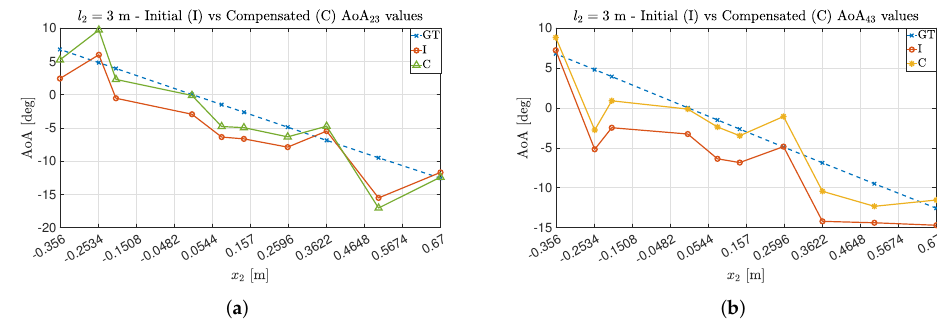
Figure 9. AoA estimation values for Exp#2 before and after compensation obtained for ( a ) the antenna couple { 23 } and ( b ) the antenna couple { 43 } .